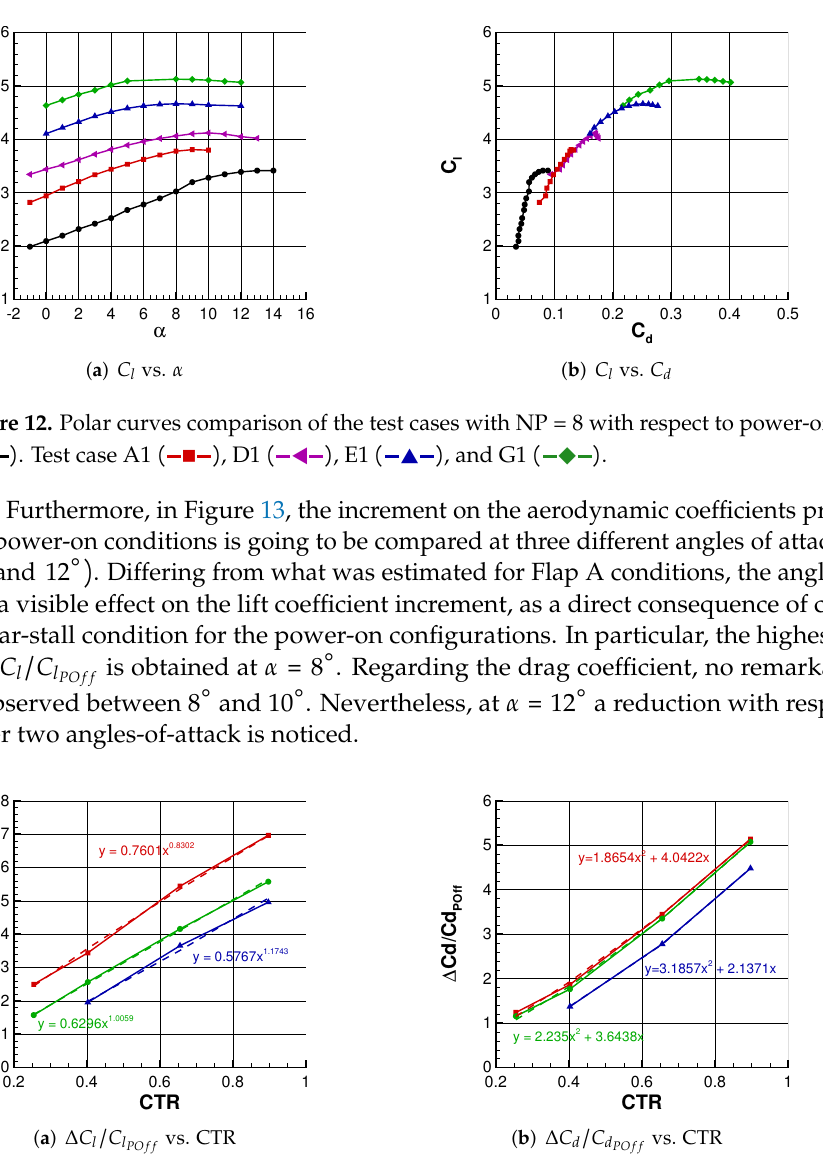
Figure 13. Increment of lift and drag coefficients at α = 8 In addition, their corresponding tendency lines are